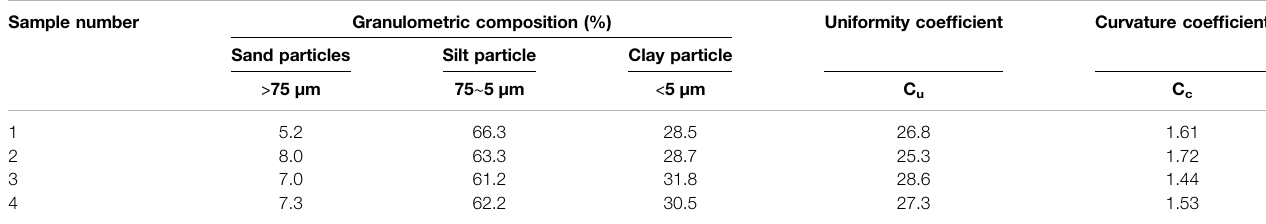
TABLE 1 | Grain size distribution of the Q 2 loess.